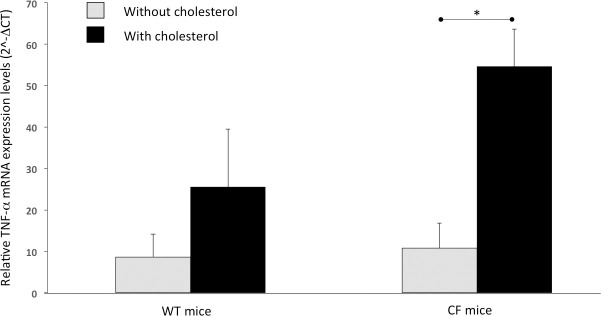
Liver expression of TNFα mRNA normalized on β-2–microglobulin expression levels.Error bars correspond to standard error. Comparisons between two groups were performed by unpaired Student t test. * p < 0.05.